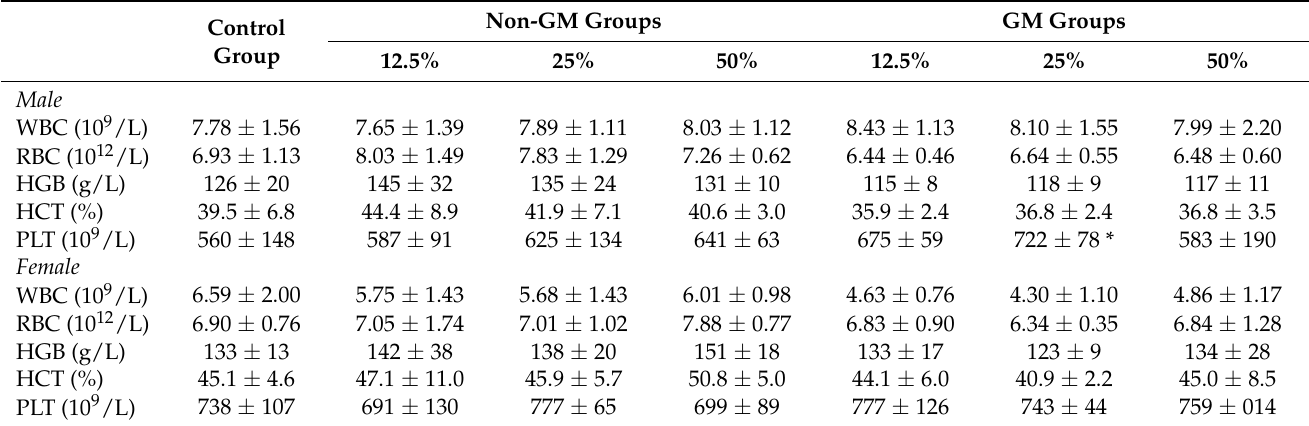
Table 7. Hematology of male and female rats feed with different diets ( n = 10).